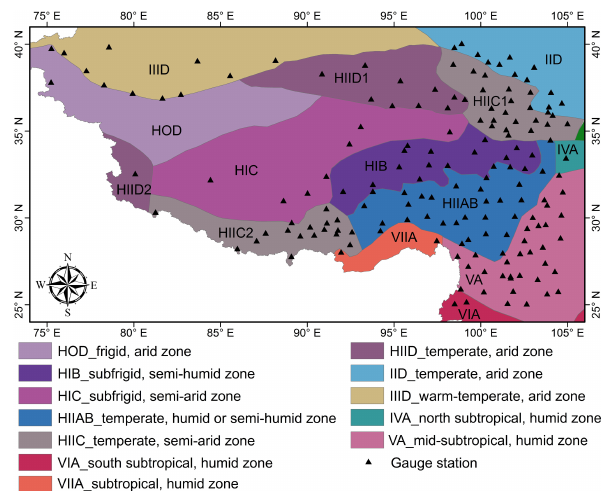
Fig. 2. The climate zones over the Tibetan Plateau and its peripheral areas and the 166 rain gauges (Sun and Zheng, 1999).